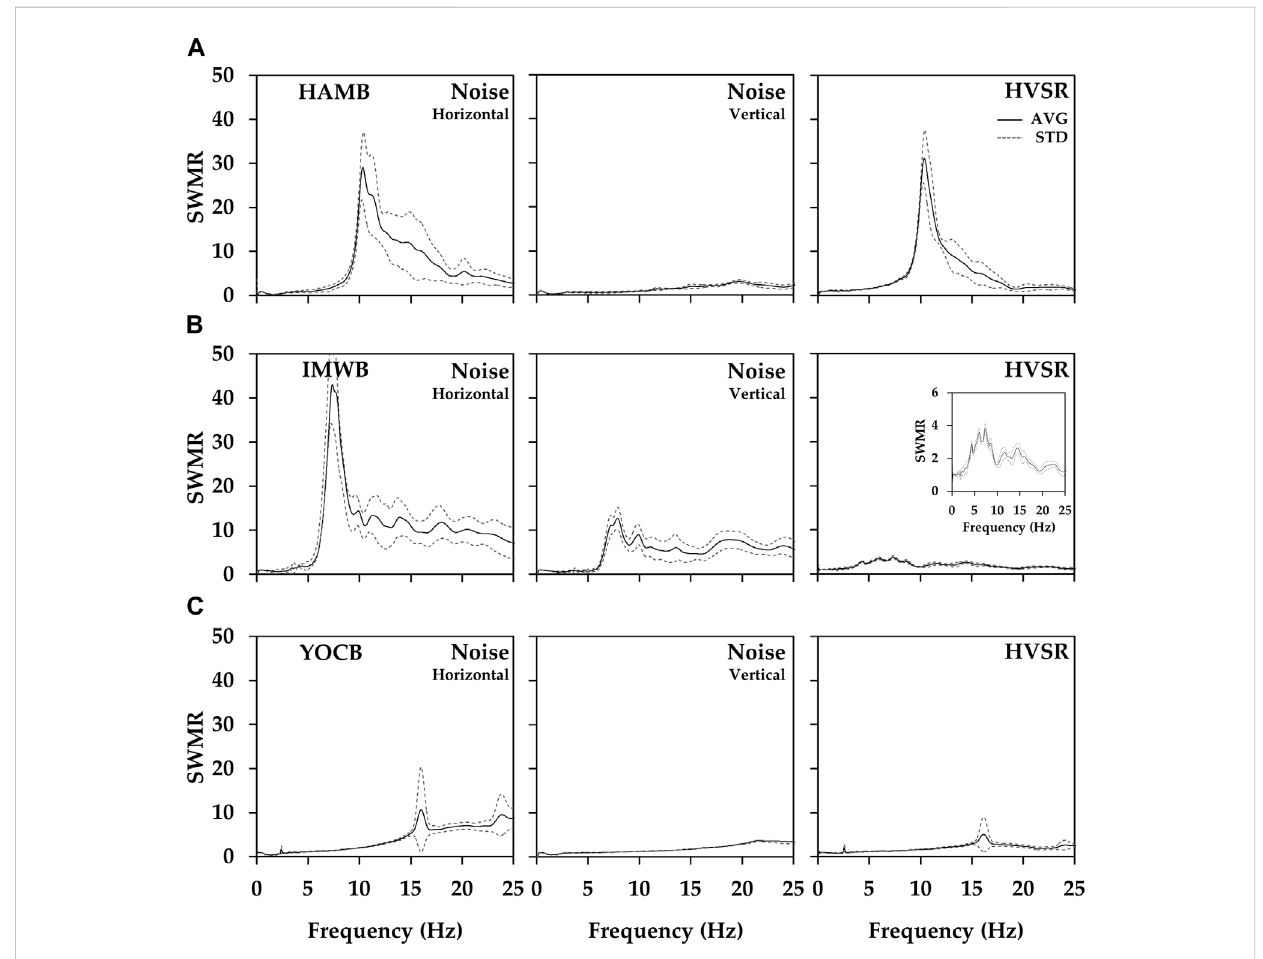
Comparison of surface-to-within motion ratio (SWMR) based on ambient noise. Panels on the left represent the horizontal spectral ratios (H surface / H borehole ); center panels are the vertical spectral ratios (V surface /V borehole ); and right panels are the HVSR ratio (HVSR surface /HVSR borehole ).